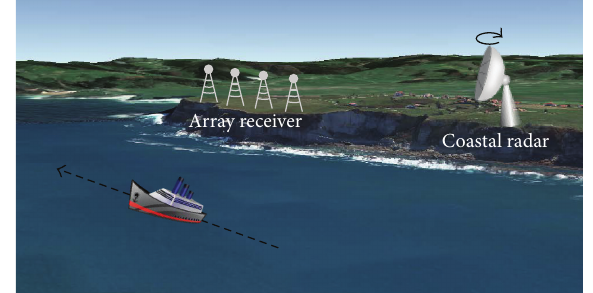
Figure 1: Operative scenario.